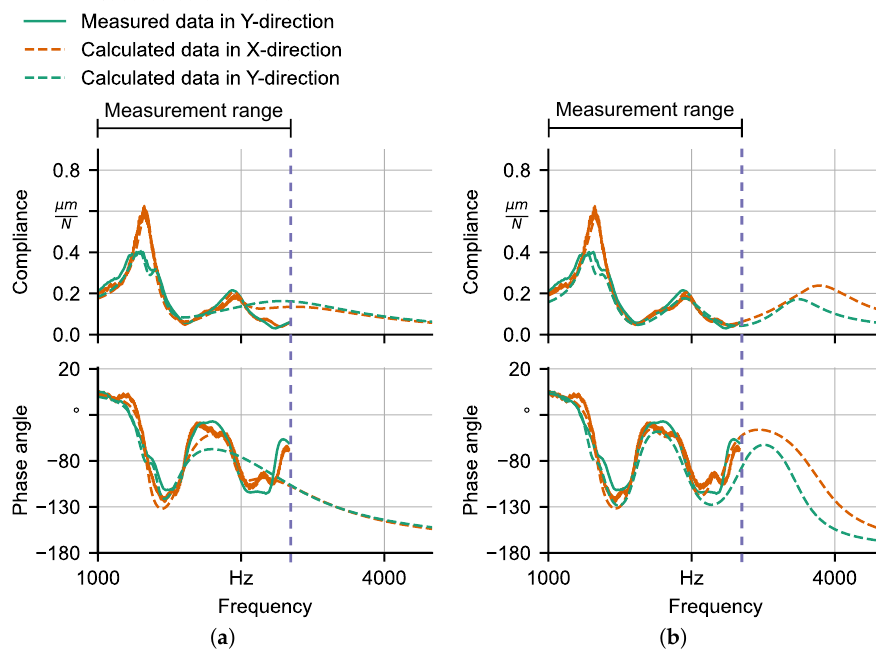
Figure 4. Comparison of measured and calculated FRFs, where the calculation is either based on compliance models whose natural frequencies ( a ) entirely lie inside the considered frequency range or ( b ) use exactly one oscillator that had a fixed natural frequency outside the measured upper frequency